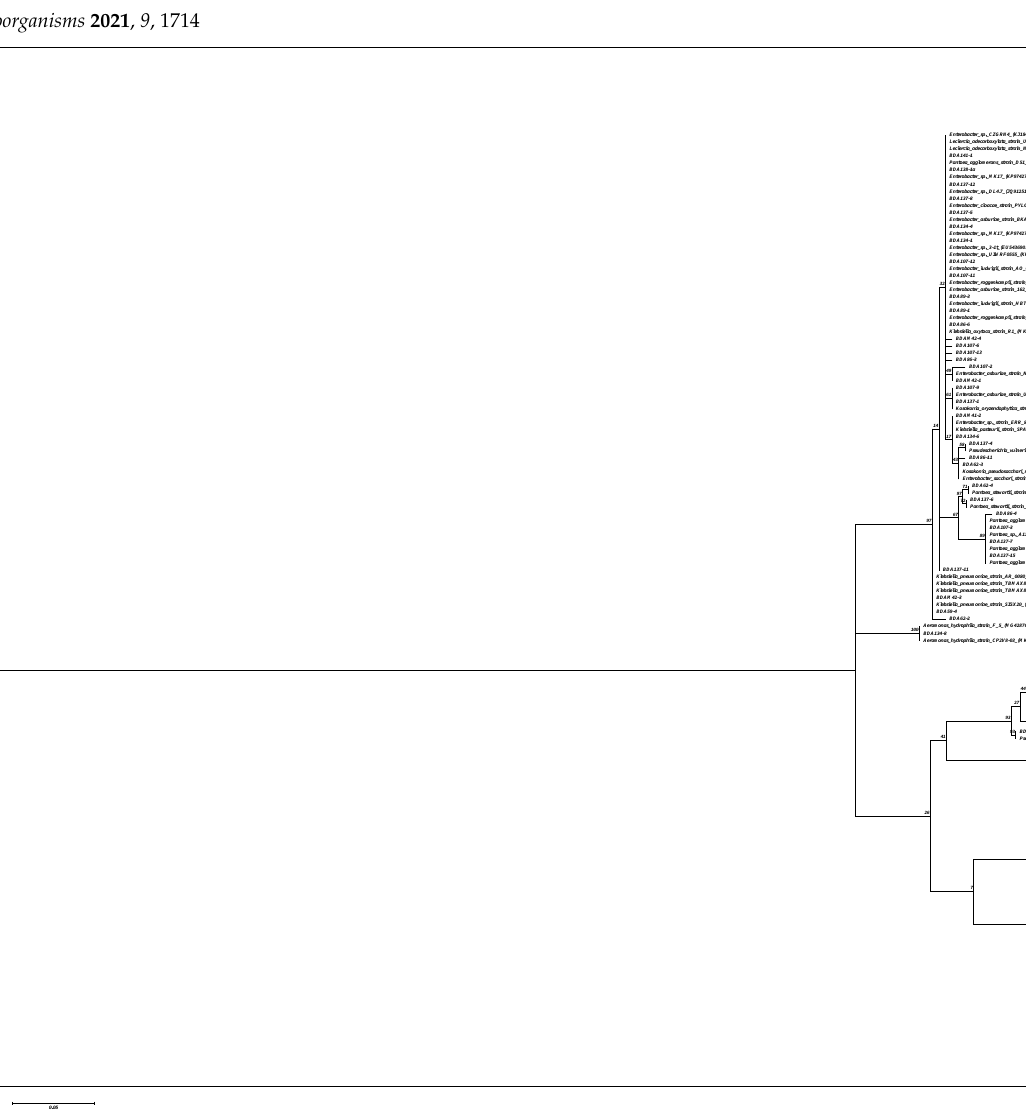
Figure 1. Phylogenetic tree based on the 16S rRNA gene sequences corresponding to endophytic strains inhabiting rice tissues. The sequences for closely related strains were recovered from GenBank and included in the tree. The accession numbers of these strains are shown in